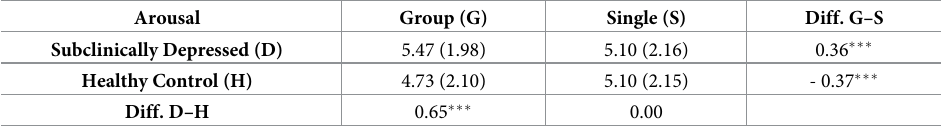
Table 10. Arousal before feedback by treatment.